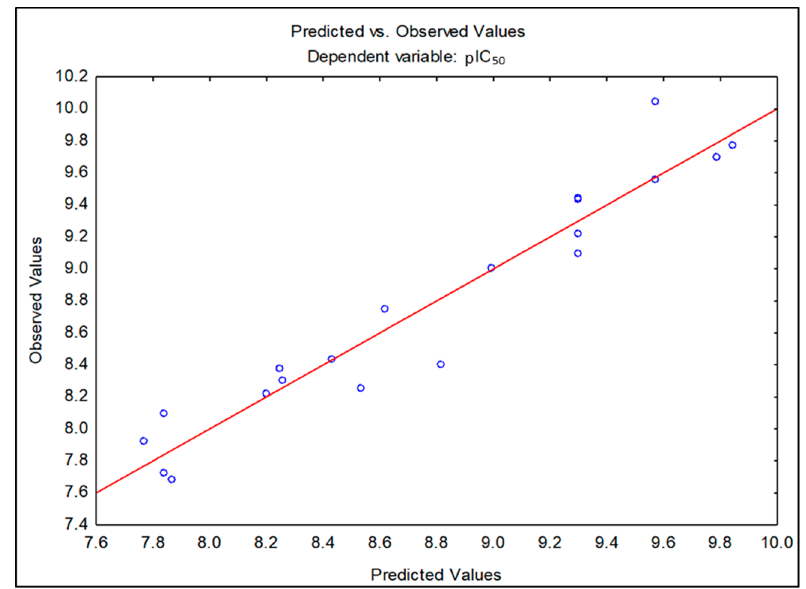
Figure 4. Linear correlation graph of the tetra-parametric model.